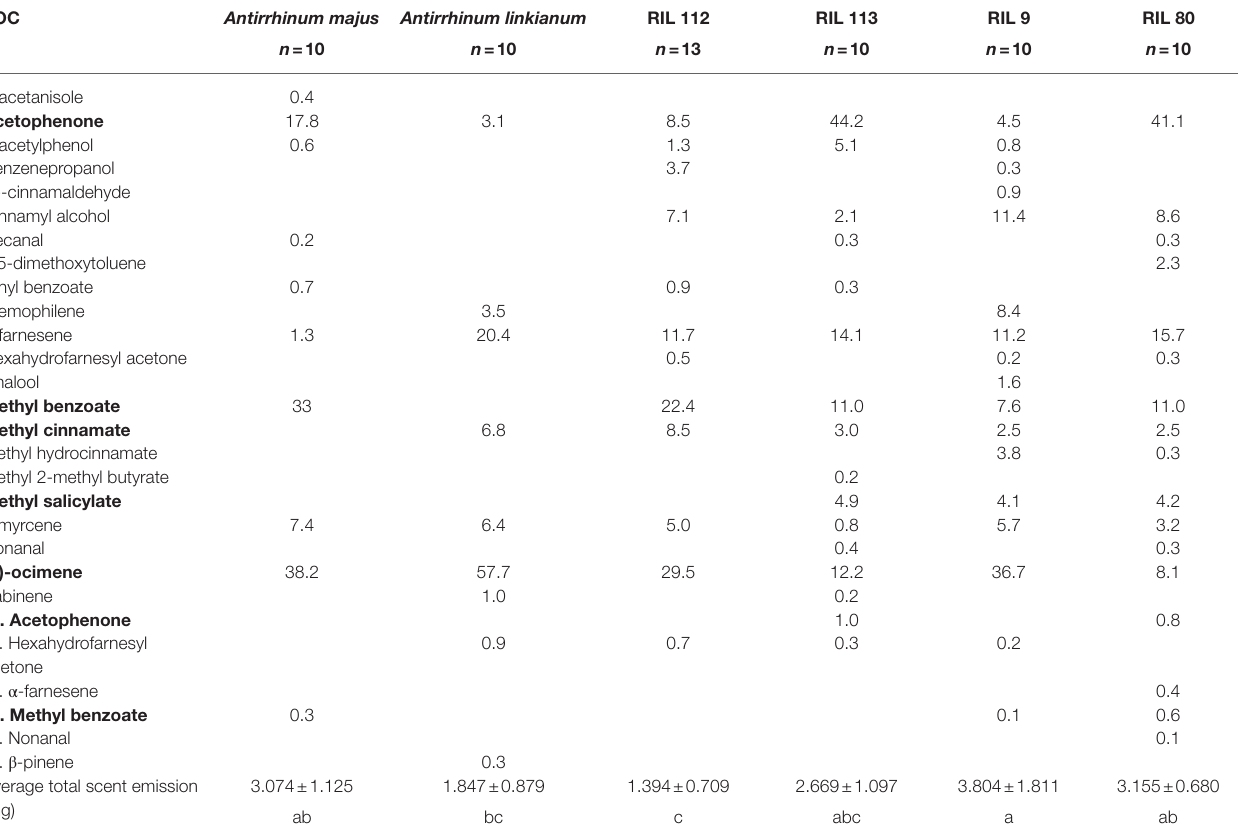
TABLE 1 | Mean percentage of VOCs in scent profiles of A. majus , A. linkianum , and RILs 112, 113, 80, and 9. VOC Antirrhinum